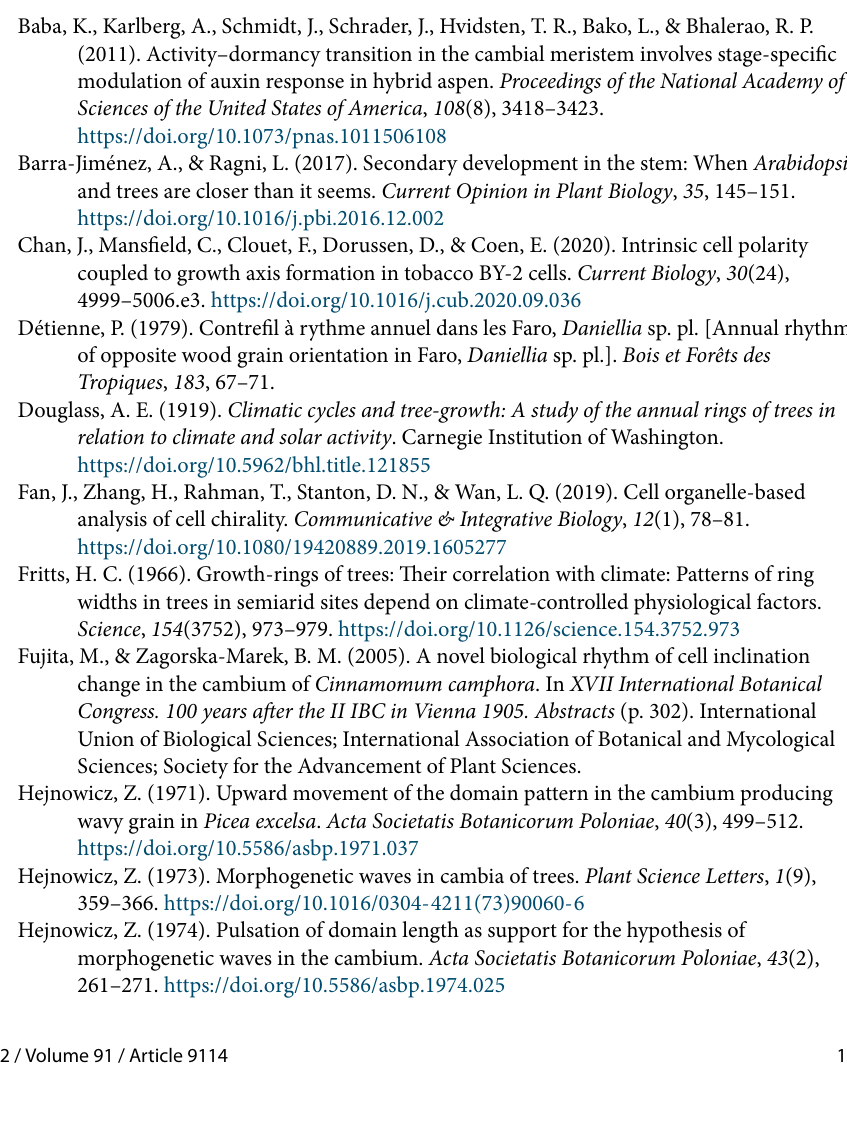
Figure S2. Cryptomeria japonica – e bottom surface of the fallen tree log reveals some sequences of wider and thinner annual rings shiing laterally along the circumference. Figure S3. Microscopic view of the transverse sections through secondary xylem of Clethra and Fagus